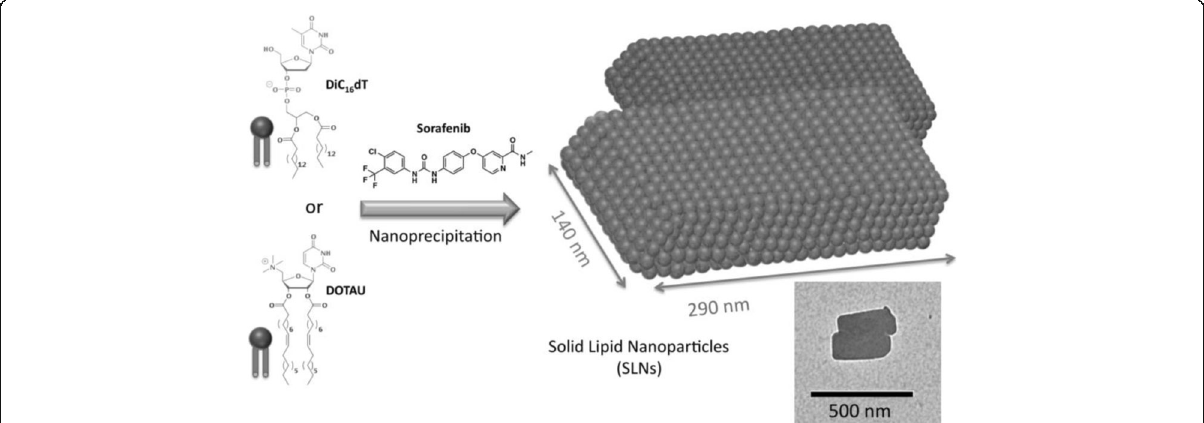
Fig. 1 Scheme of SLNs formulation. Chemical structures of an anionic nucleotide-lipid, the thymidine 3 ′ -(1,2-dipalmitoyl- sn -glycero-3-phosphate) (diC 16 dT), a cationic-nucleoside-lipid DOTAU (2 ′ ,3 ′ -dioleyl-5 ′ -deoxy-5 ′ -trimethyl-ammonium-uridine), and sorafenib used in this study (left). Schematic drawing of SLNs with parallelepiped shapes obtained after nanoprecipitation of a nucleolipid (either diC 16 dT or DOTAU, leading to SLN − and SLN + , respectively) with sorafenib (right). The schematic representation is adapted from the transmission electronic microscopy (TEM) image showing DOTAU sorafenib-loaded nanoparticles (inset, bar 500